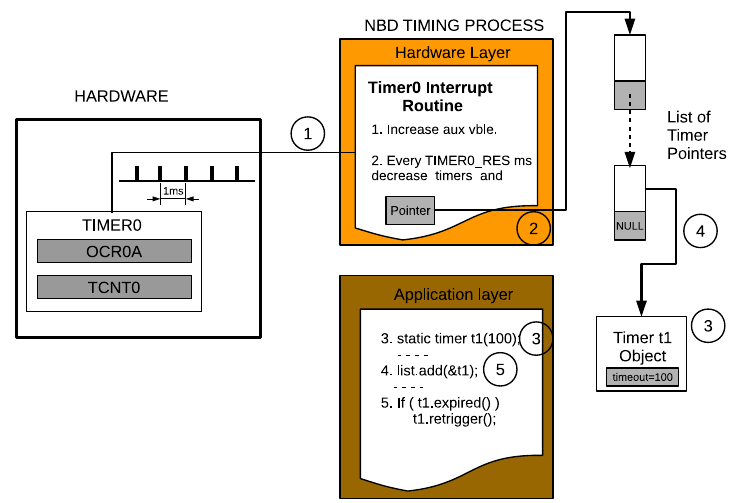
Figure 4. Support for non-blocking delays through Timer0 interrupts. Every 1 ms (1), an interrupt is generated, which makes an interrupt routine increase the aux variable. Every 10 ms (the default timer resolution), this routine searches for a list (4) of declared (3) and installed (5) timers in order to decrease their values. For example, Timer1 in the figure would expire after 1